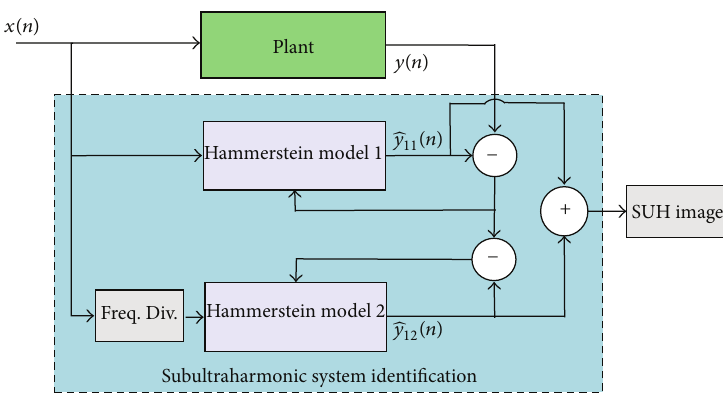
Figure 4: Block diagram of method 1, modeling by input frequency